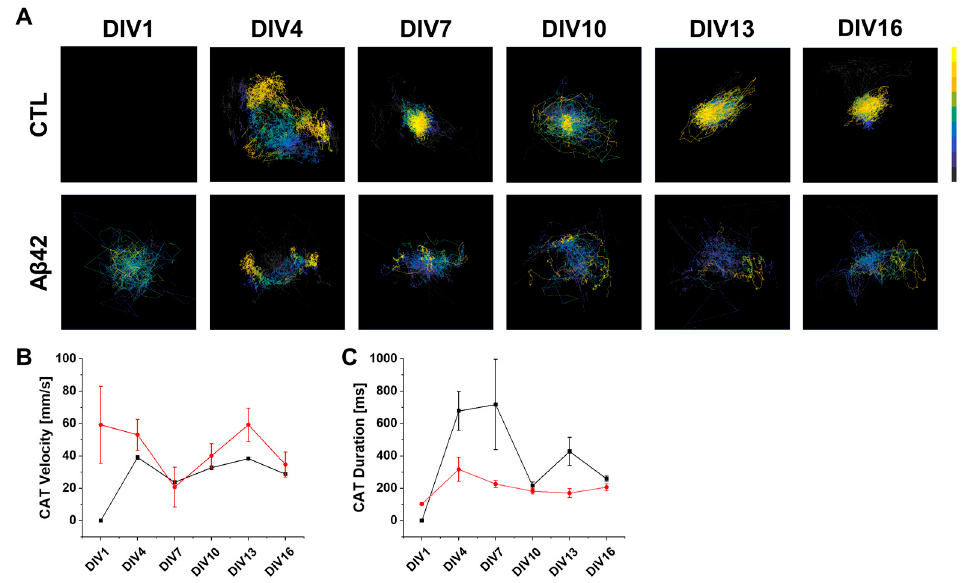
Figure 4. CAT analysis in the developing neuronal cultures. ( A ) CAT analysis images of control (CTL) and A β 42 oligomer treatment groups in DIV1, 4, 7, 10, 13, and 16. The color scale bar represents initiation (gray) to termination (yellow). ( B ) Line plot of CAT velocity with variation (vertical line) in millimeters per second for control (black) and A β 42 oligomer treatment (red) groups. ( C ) Line plot of CAT duration with variation (vertical line) in milliseconds.